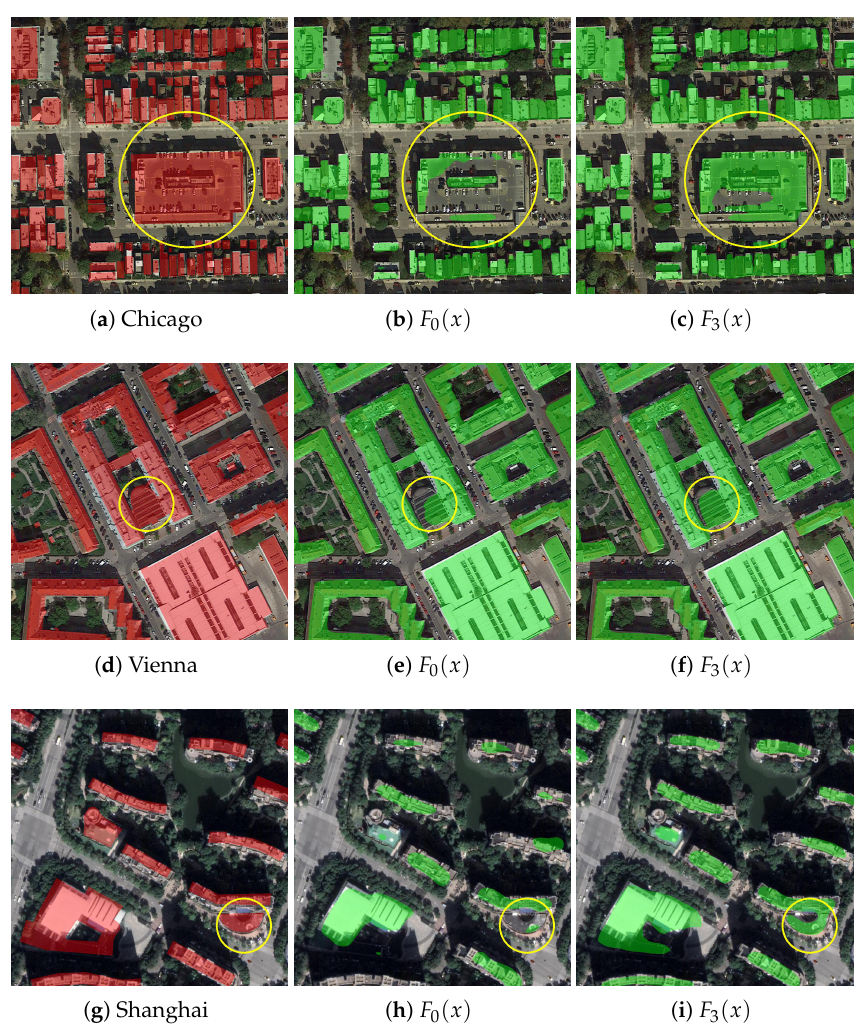
Figure 7. Semantic segmentation results of GeoBoost from the cities of Chicago, Vienna, and Shanghai. The figures of ( a , d , g ) colored in red are the ground truth of images. The figures of ( b , e , h ) colored in green are the results of F 0 ( x ) , and the figures of ( c , f , i ) are the results of F 3 ( x ) . The yellow circles